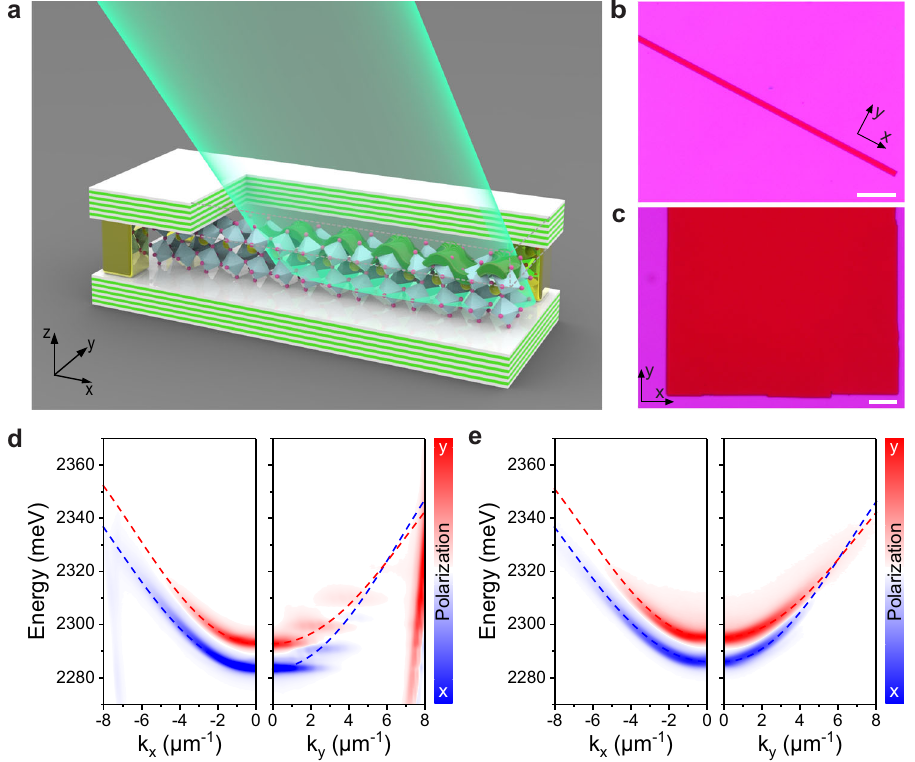
Fig. 1 | Sketch ofexperimental con fi guration and characterizations ofCsPbBr 3 microwire and plate. a Schematics of polariton fl uid experiments. The polariton fl uid was resonantly pumped by a fs pulse laser, and the signal wasdetected in the transmission con fi guration (Supplementary Fig. 4). b , c are the optical images of a perovskite microwire and a plate under transmission con fi guration, respectively. Scale bar: 20 μ m. d , e are the linear-polarized dispersions of photoluminescence (PL) of a perovskite microwire with a width of 1.85 μ m and a plate along the